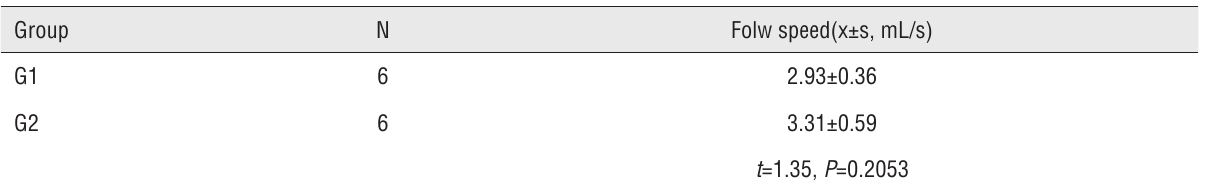
Table 2 - Flow rate